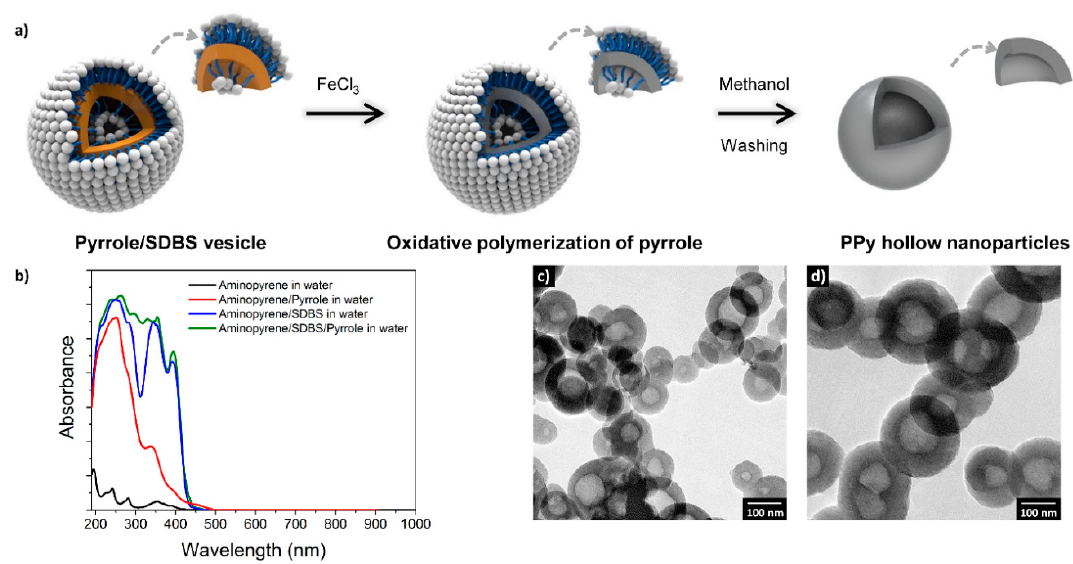
Figure 7. Preparation of PPy hollow nanoparticles. ( a ) Schematic of the formation mechanism, ( b ) UV-vis absorption spectra of aminopyrene in different solvents; ( c , d ) Transmission electron microscopy (TEM) images of the hollow PPy nanoparticles with diameters of 100 and 200 nm, respectively. Reprinted with permission from [67]. Copyright 2015, Nature Publishing Group.